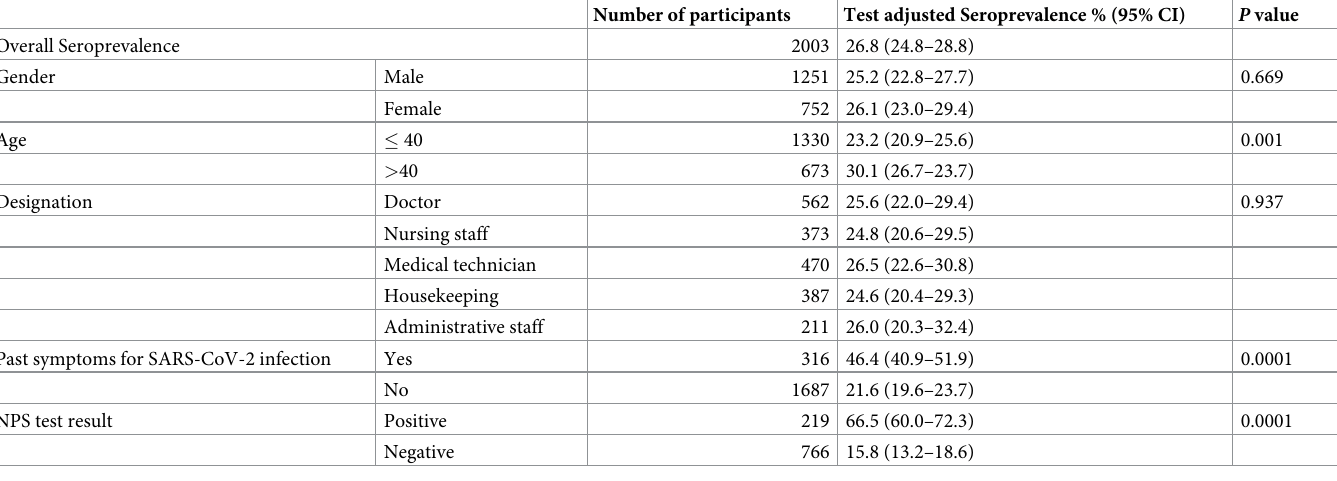
Table 1. Seroprevalence of SARS-CoV-2 IgG antibodies by sociodemographic features of health care workers.